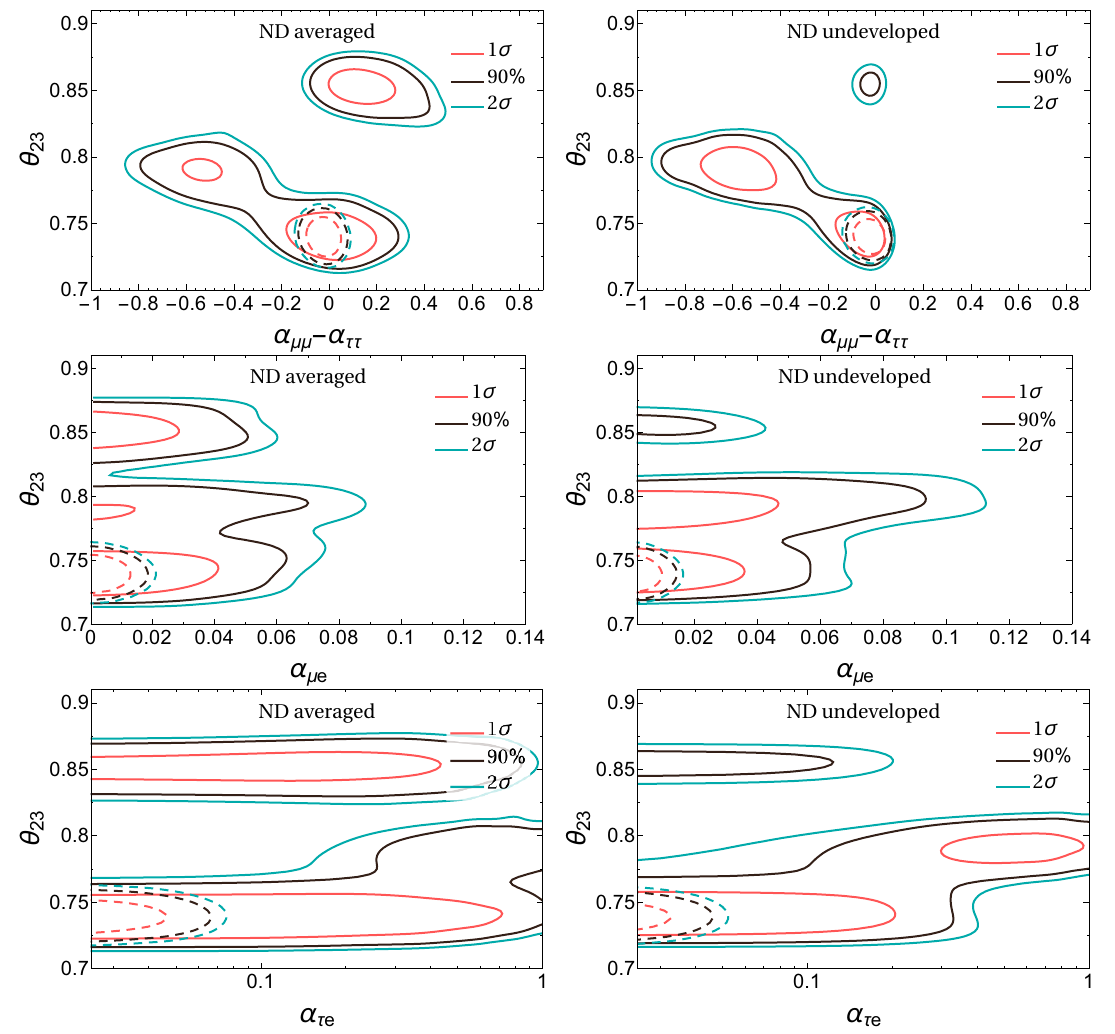
Figure 2 . Expected frequentist allowed regions at the 1 (cid:27) , 90% and 2 (cid:27) C.L. for DUNE. All new physics parameters are assumed to be zero so as to obtain the expected sensitivities. The left panels (ND averaged) correspond to the non-unitarity case, or to the sterile case when the light- heavy oscillations are averaged out in the near and far detectors. The right panels (ND undeveloped) give the sensitivity for the sterile case when the light-heavy oscillations have not yet developed in the near detector, but are averaged out in the far. The solid lines correspond to the analysis of DUNE data alone, while the dashed lines include the present constraints on sterile neutrino mixing from the middle and right columns in table 1 for the ND averaged and ND undeveloped scenarios